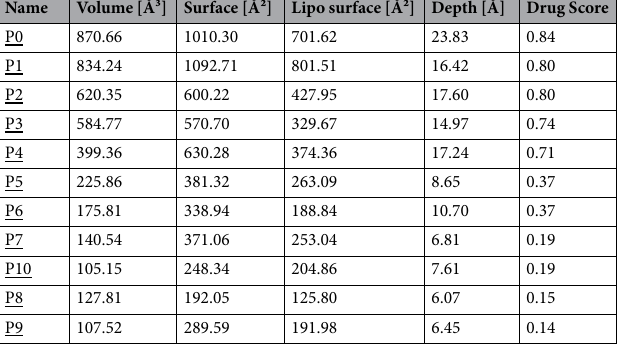
Table 1. Active Site analysis of the Protein Ror1 using